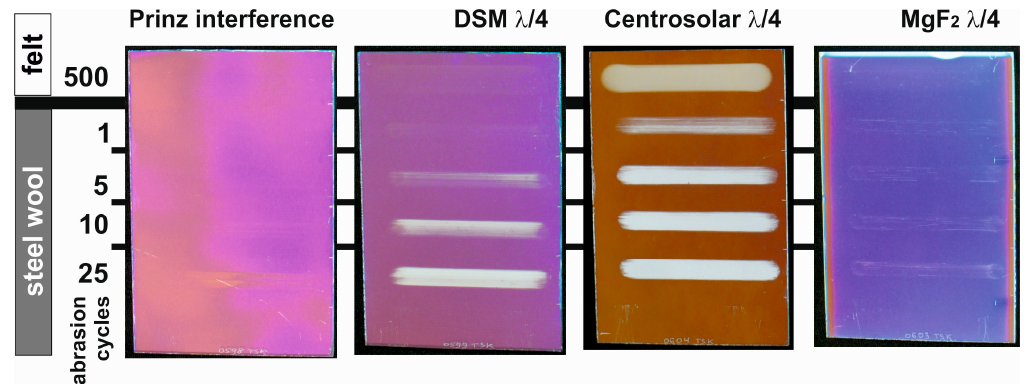
Figure 16. Photographs of commercial sol-gel-based antireflective systems after Crockmeter testing in comparison to MgF 2 λ /4 films. Based on [52].